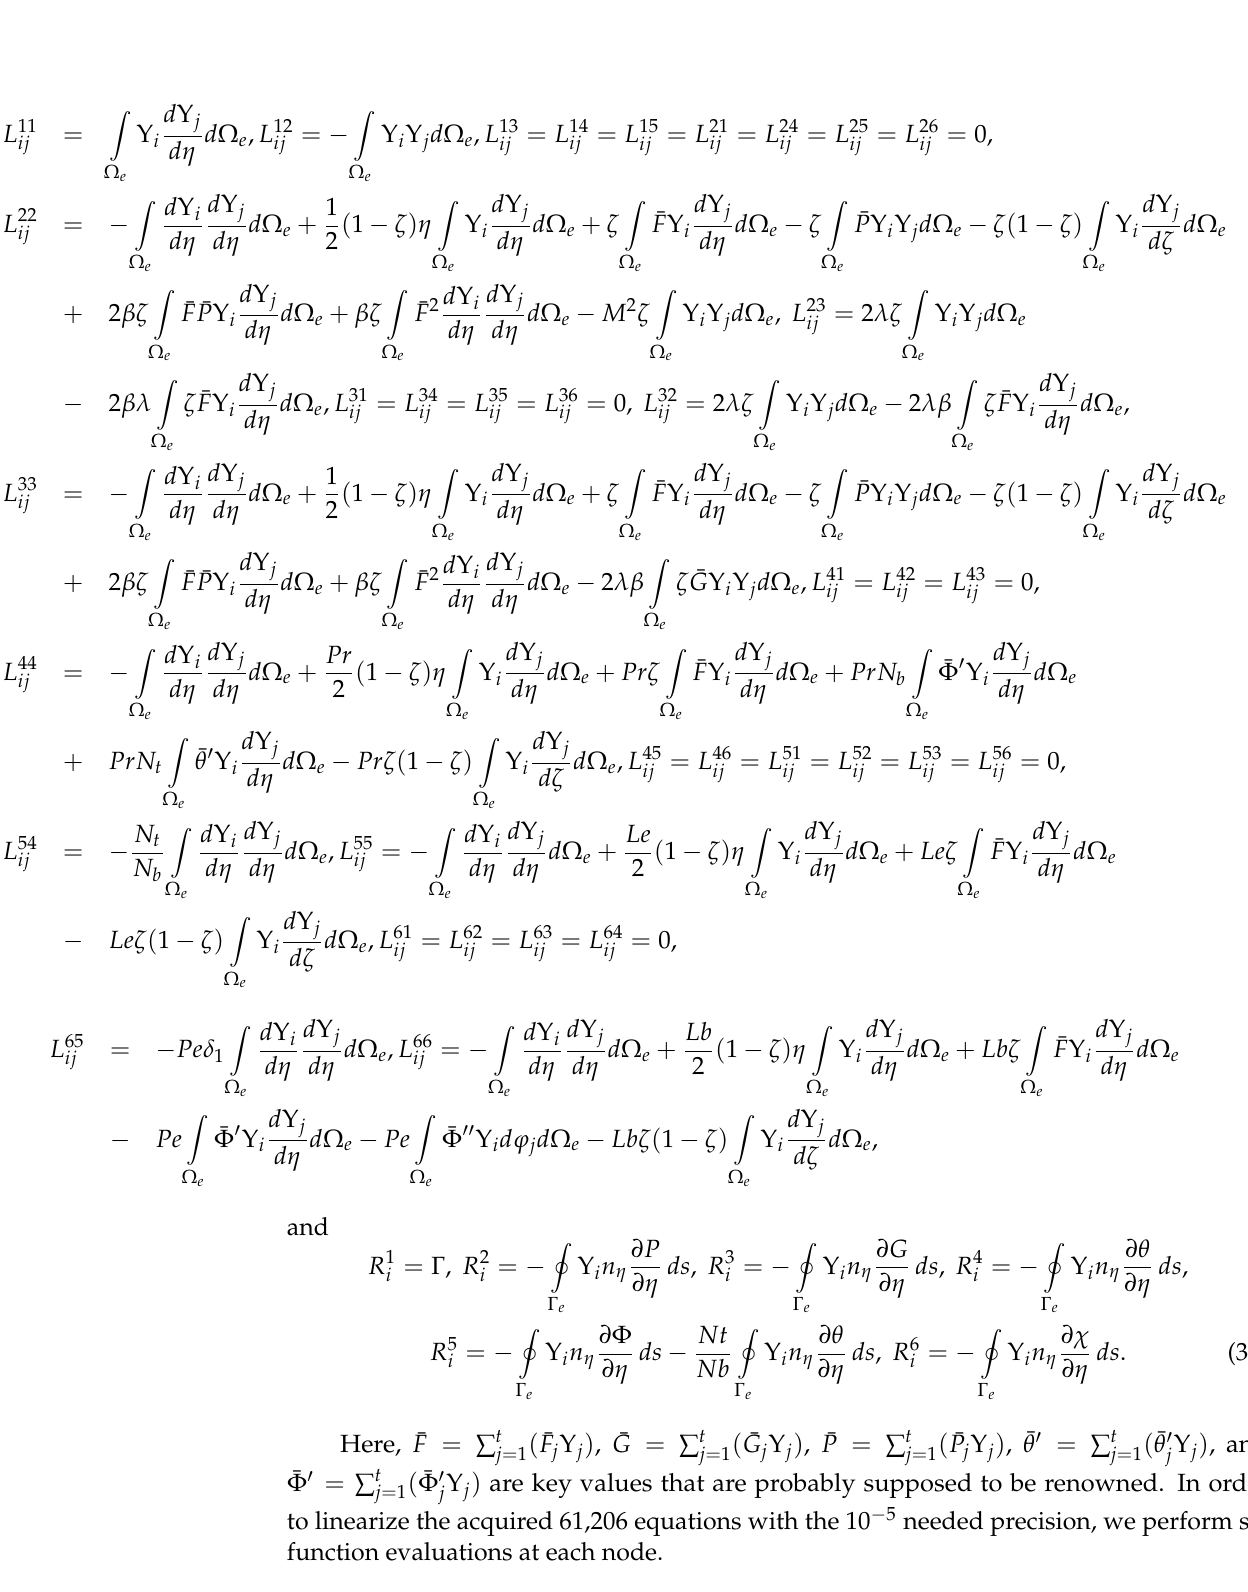
hydrodynamic effects, and micro-organisms. Three different patterns of arcs are mapped on fluctuating values of the intravenous injection/suction ( Γ ) factor for every